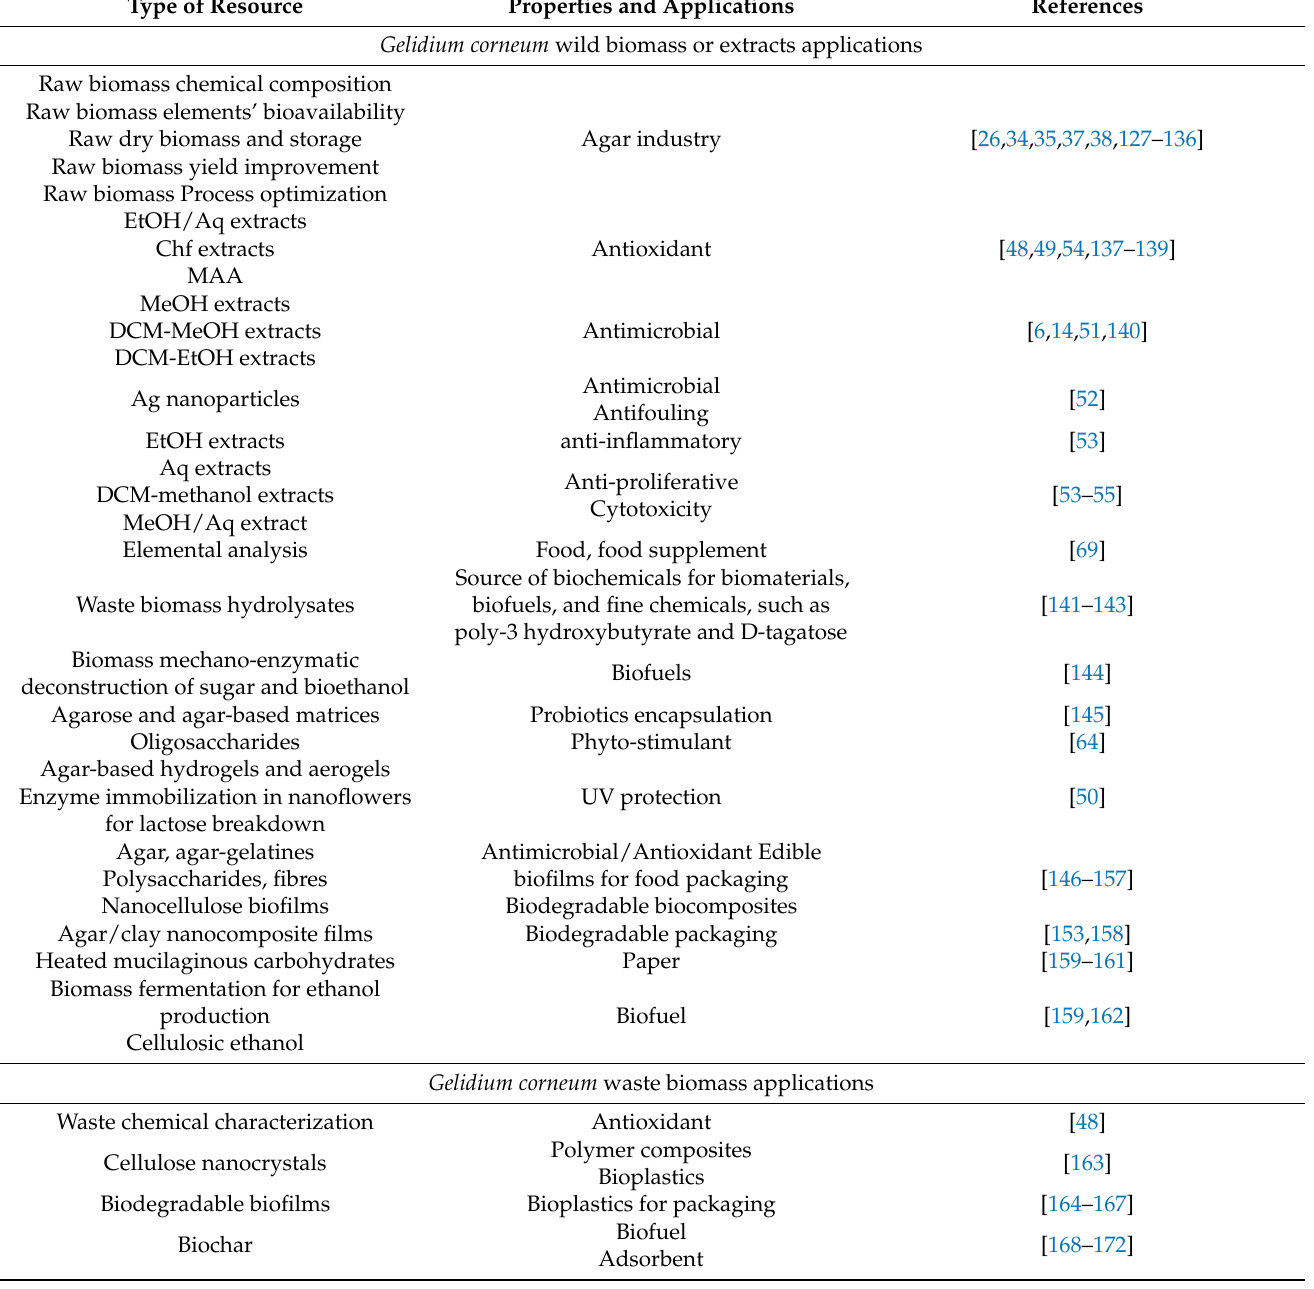
Table 2. Properties and applications of Gelidium corneum biomass, extracts, and